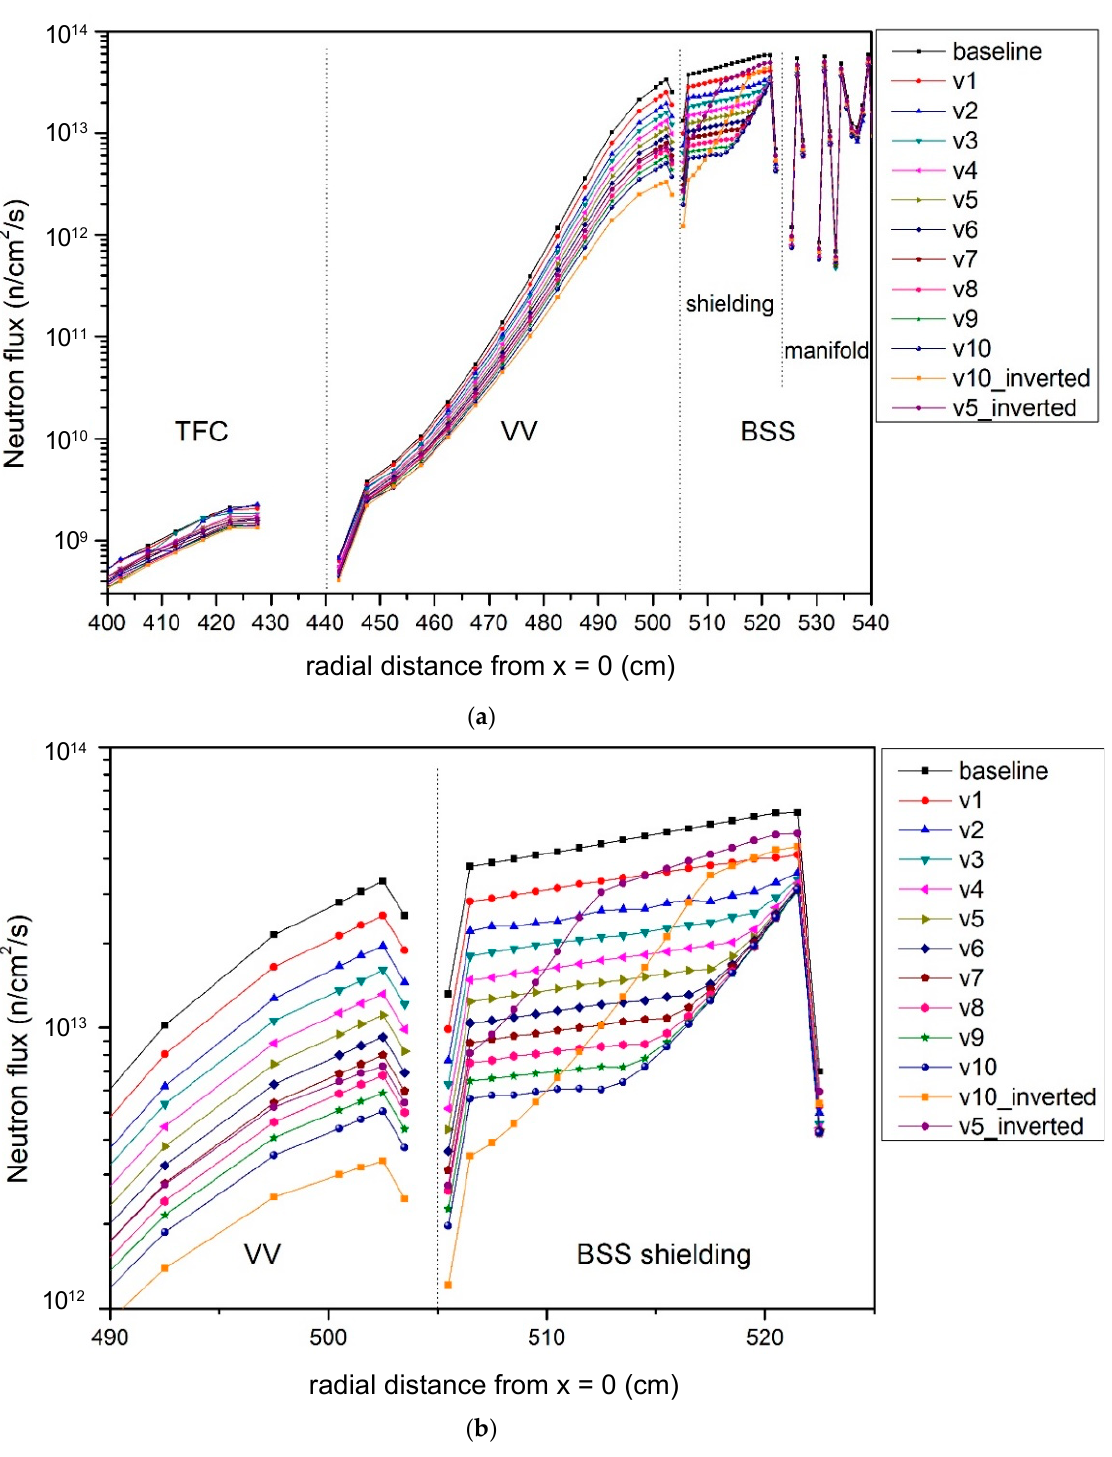
Figure 6. Neutron flux for the baseline model, the 10 modified versions, and inverted versions v5 and v10 from the BSS to the TFC ( a ); zoomed view from the BSS to the VV ( b ). The ideal would be to have a detailed design for the TFC with all structures separately described rather than a homogenized composition.